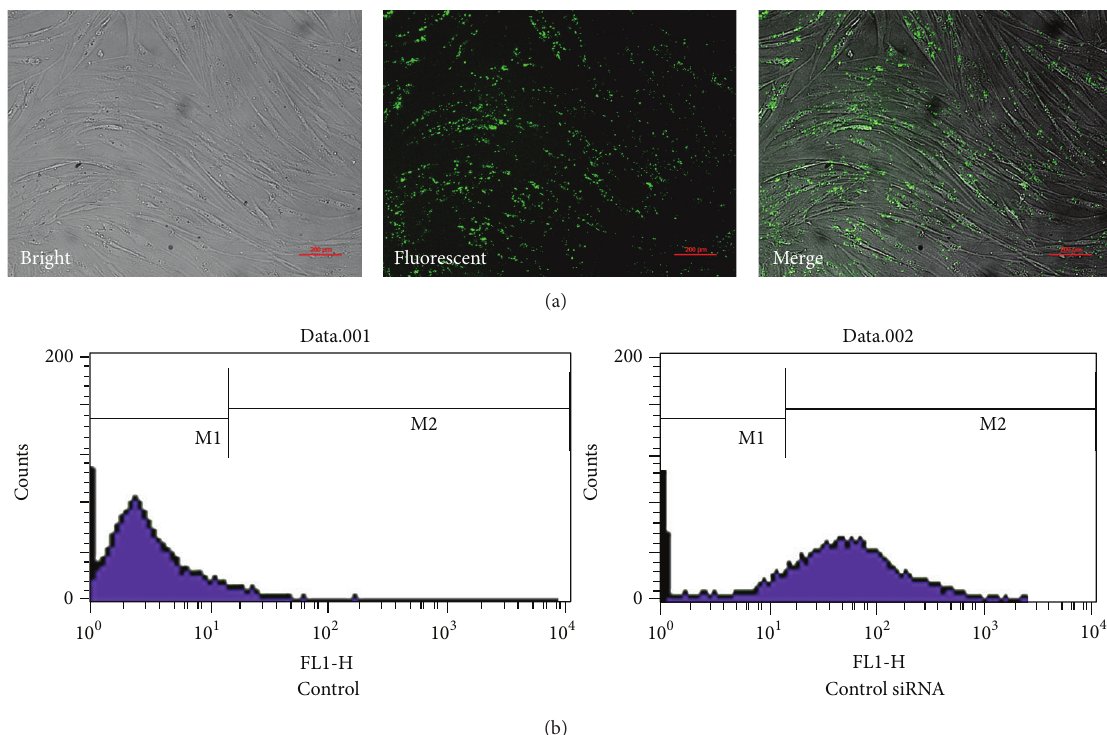
Figure 2: Transfection efficiency of siRNA. (a) Transfection efficiency of HTFs transfected with FAM-labeled control siRNA was observed by a fluorescence microscope. Green staining in cells stands for effective transfection. (b) FCM was used to analyze the transfection efficiency of siRNA. HTFs transfected with/without control siRNA were counted by FCM. Untransfected cells were marked with M1, and FAM-labeled cells were marked with M2 (here we just show one of the